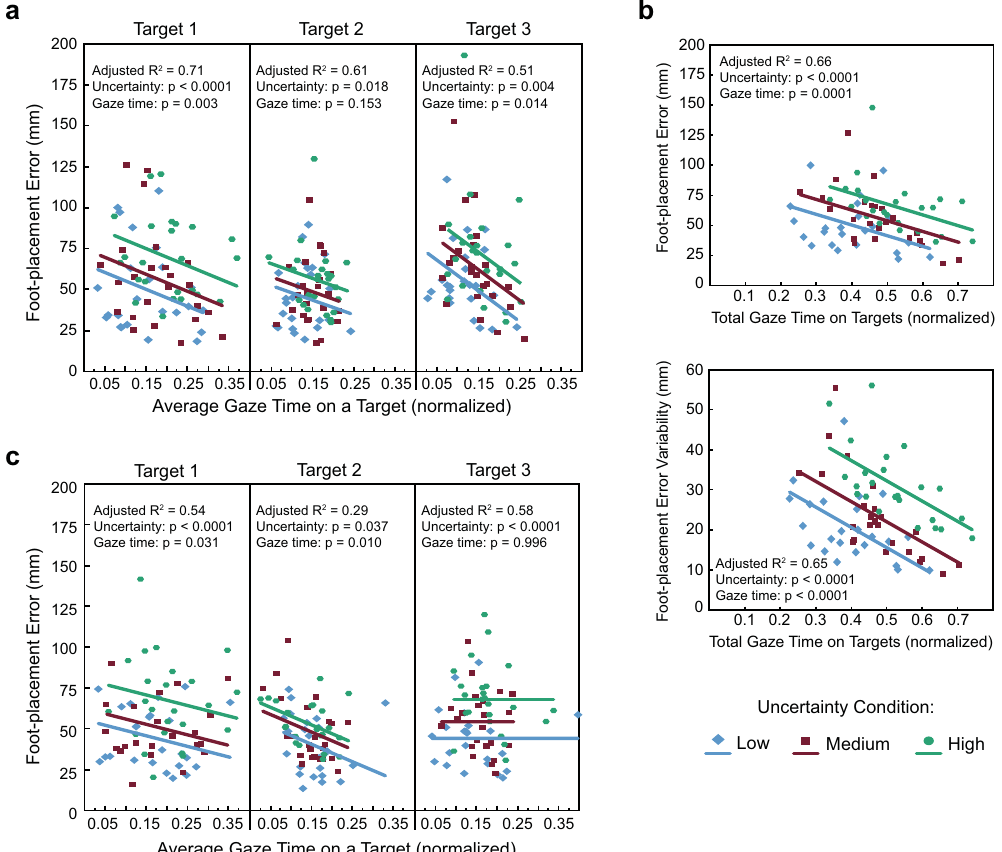
Figure 6. Relationship between gaze behaviour and foot-placement accuracy. ( a ) Scatterplots of average gaze time on a target and foot-placement error for the Low, Medium, and High uncertainty conditions in the consistent environment. ( b ) Scatterplots of total gaze time on targets and foot-placement error (top panel) or foot-placement error variability (bottom panel) for the Low, Medium, and High uncertainty conditions in the consistent environment. ( c ) Scatterplots of average gaze time on a target and foot-placement error for the Low, Medium, and High uncertainty conditions in the variable environment. Solid lines show the linear fits obtained from the